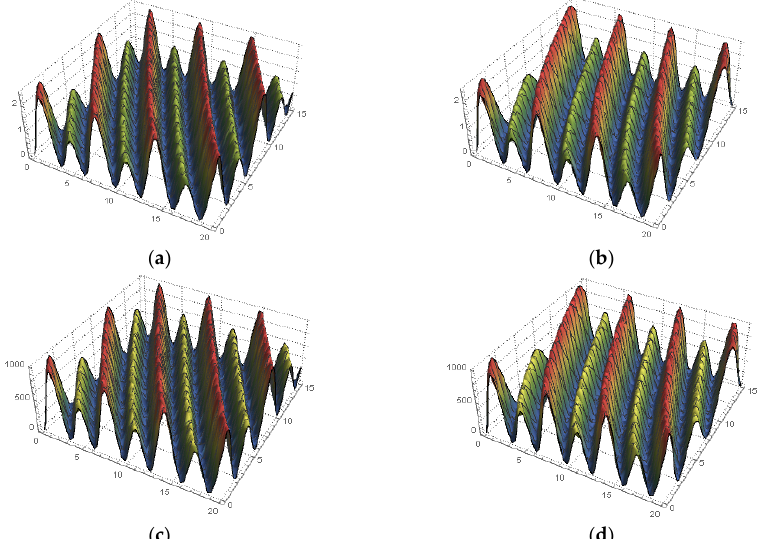
Figure 7. The 3D plots of | F 12 ( x , t ) | 2 and | G 12 ( x , t ) | 2 with the parameters r 1 = r 2 = − 3, k 1 = k 2 = 1, q 0 = 7, p 2 = 2, q 1 = − 5, ρ = 0.5 and τ = 0 for various α values: ( a ) | F 12 | 2 , α = 0.95, ( b ) | G 12 | 2 , α = 0.95, ( c ) | F 12 | 2 , α = 0.75 and ( d ) | G 12 | 2 , α = 0.75.